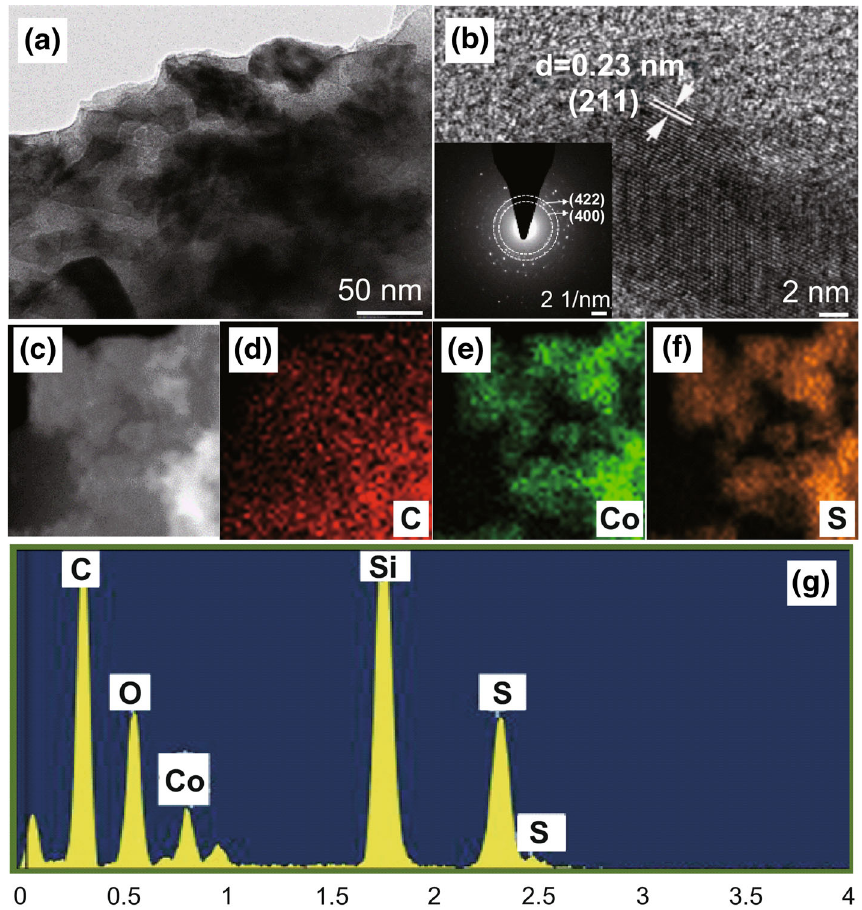
Fig. 5 a TEM image, b HRTEM image (inset is SAED pattern), c – f STEM image and corresponding element mappings of the CoS 2 –rGO composite and g EDS spectrum of CoS 2 –rGO